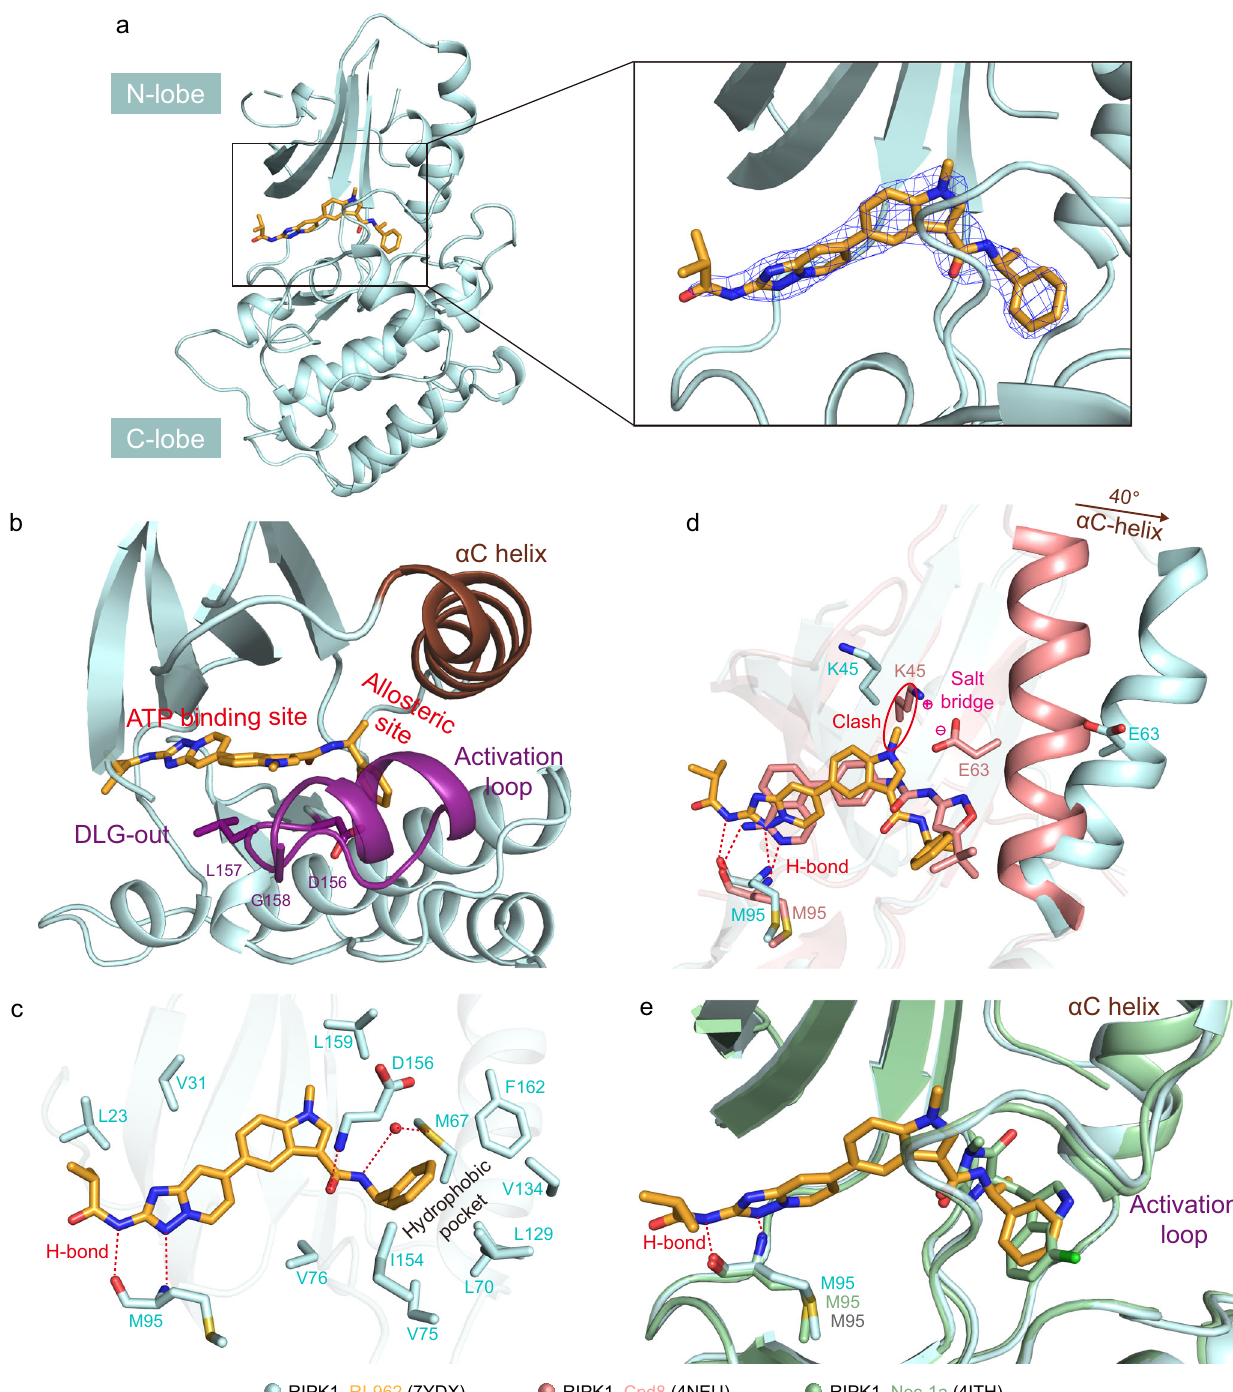
Fig. 6 | Co-crystal structures of RIPK1 complexed with RI-962 (PDB ID: 7YDX). a The binding site of RI-962. 2 Fo - Fc electron density map (contoured at 1.0 σ , blue mesh) is shown for RI-962 (in orange). b RI-962-bound RIPK1 adopts an inactive conformation. The α C-helix is colored in chocolate, and the activation loop is coloredindeeppurple.PositionofRI-962(inorange)inDLG-outstructure(sphere, in deep purple) is shown. c Interactions between RI-962 and the RIPK1 kinase domain (key residues are shown as pale cyan sticks). d Superimposition of the co-